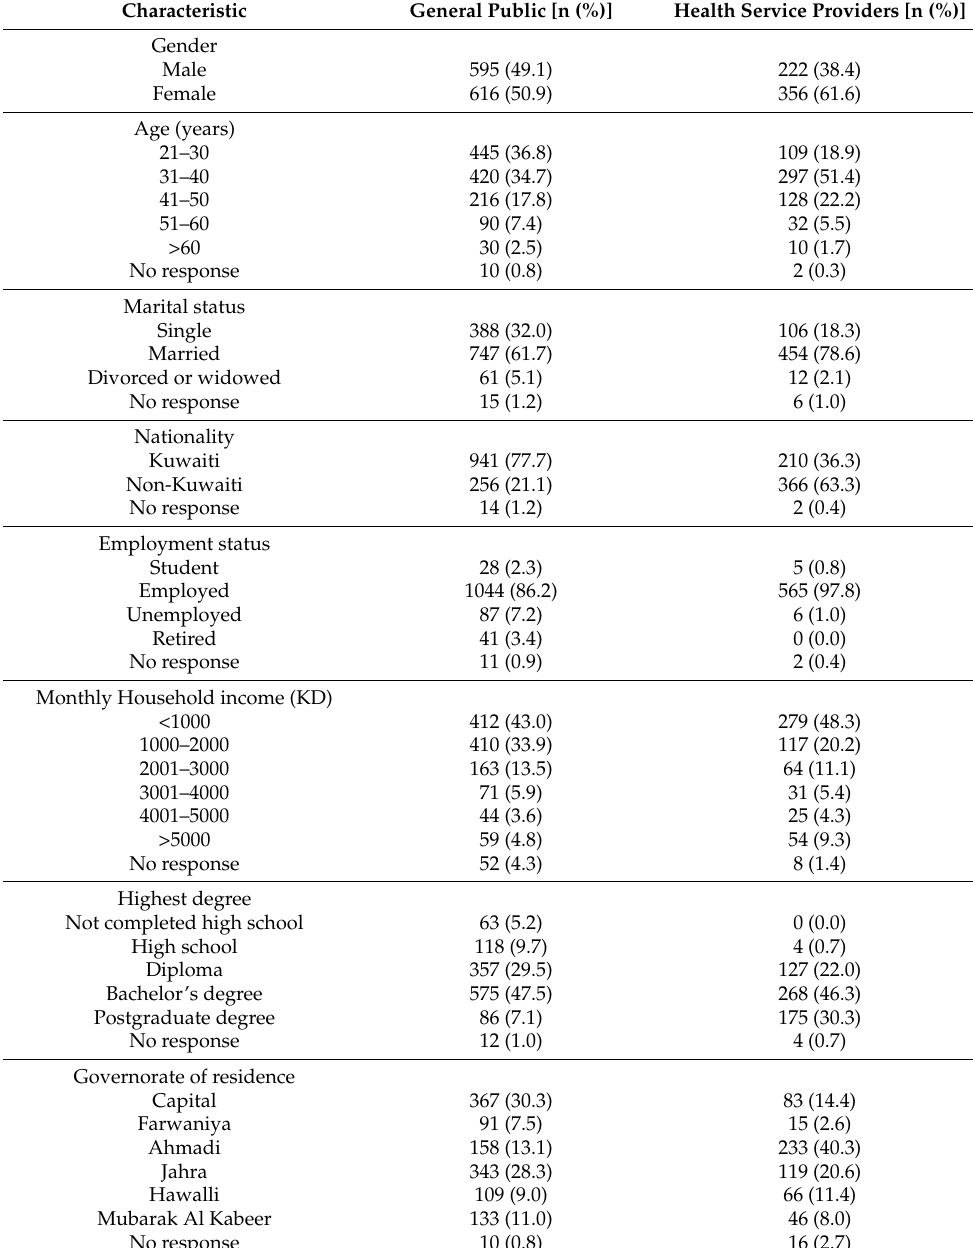
Table 3. Characteristics of the